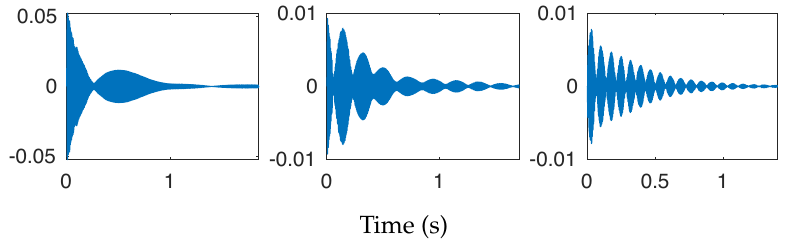
Figure 5. Signals for the first three partials of a tone showing the increased rate of